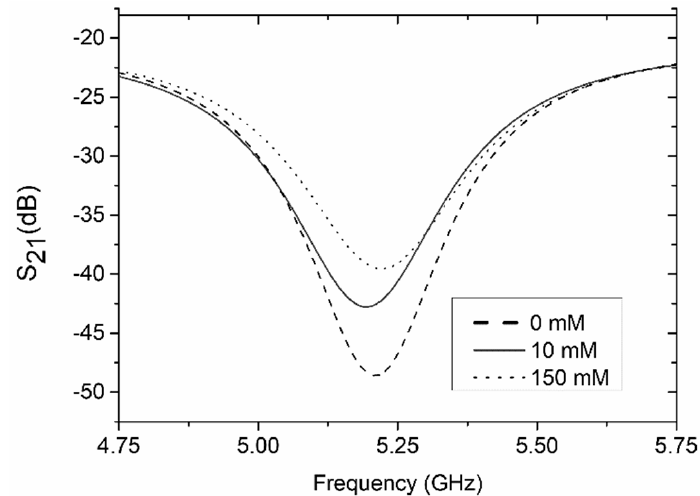
Figure 17. Measured transmission coefficient of the coupler-based sensor for various concentrations of dopamine (reference channel filled with buffer).